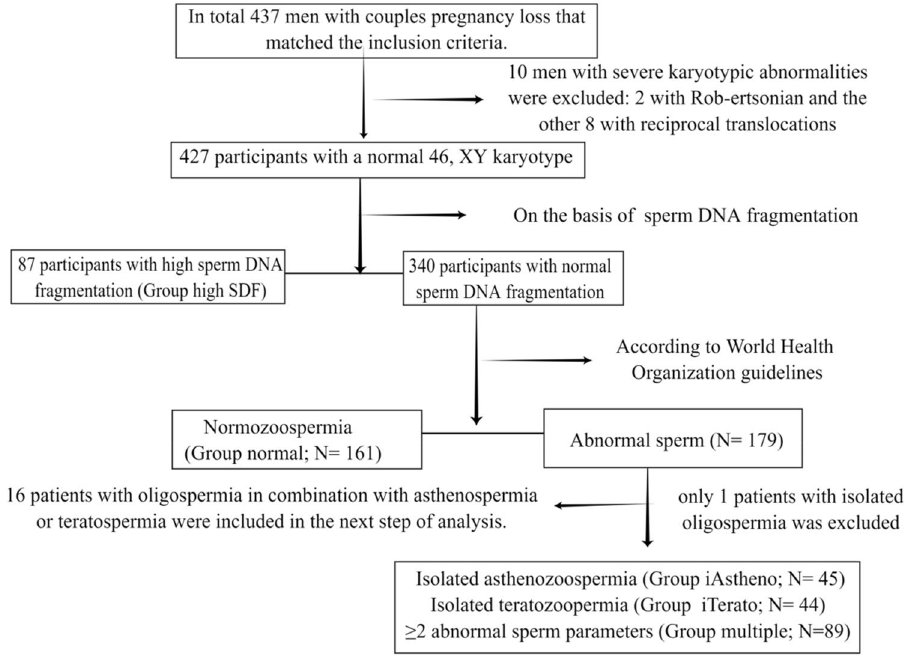
Figure 1. Flow chart of patient inclusion for this study.